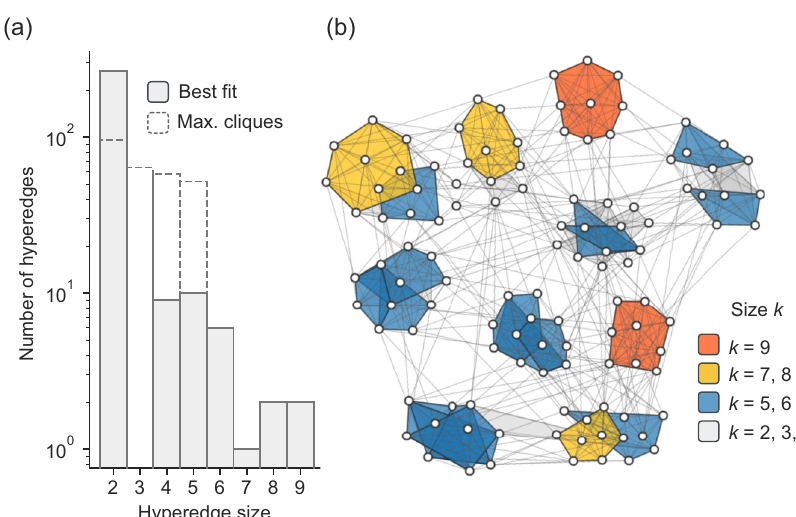
Fig. 5 Higher-order interactions uncovered in the network of American football games. a Size distribution of the hyperedges of the hypergraph H * that maximizes the posterior probability or, alternatively, minimizes the description length of the network of football games G . Also shown is the distribution of hyperedge sizes for the hypergraph constructed by assigning a hyperedge to every maximal clique of G (dashed histogram). b Visualization of the hyperedges present in H *, color-coded by size.